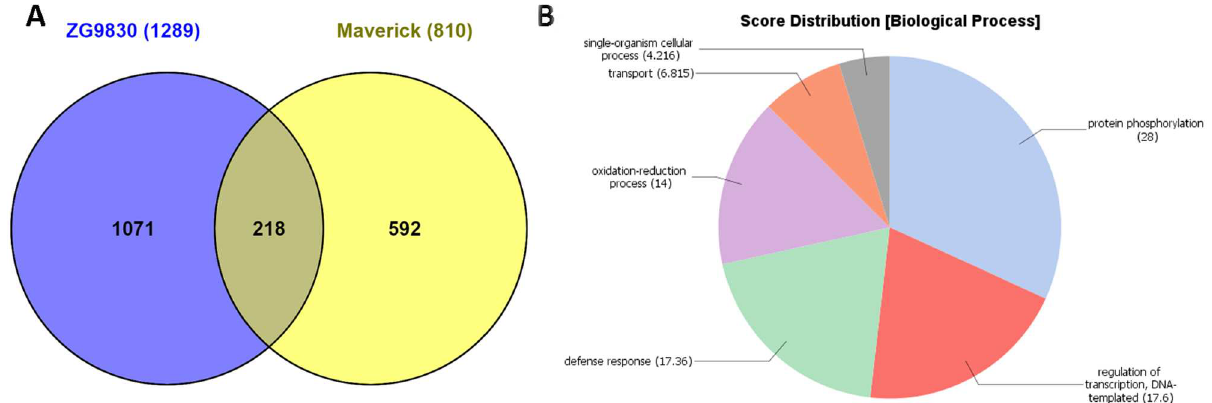
Fig 6. Comparison of differentially expressedgenes (DEGs) in resistant plants from Maverick and ZG9830. (A) Venn diagram depictingthe numberof common DEGs betweenresistant plants. (B) Functional categorization of biologicalprocessesassociatedwith resistanceresponses to P . syringae in plants from cv. Maverick and cv. ZG9830.